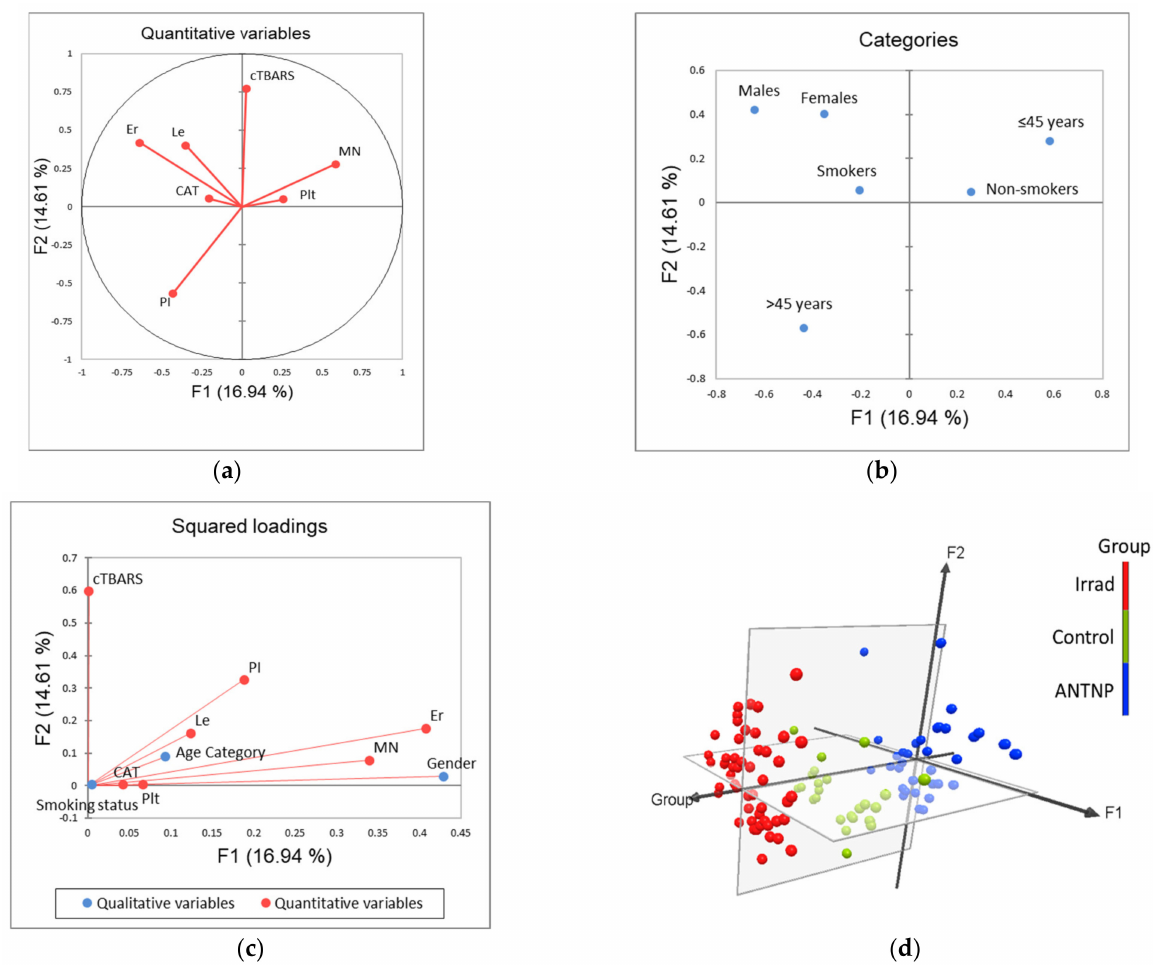
Figure 3. Principal component analysis: ( a ) correlation circle (quantitative variables); ( b ) factorial map of categories; ( c ) squared loadings of all evaluated variables; ( d ) position of evaluated cases in the space defined by the first two principal components. Control—unexposed volunteers; ANTNP—workers exposed to antineoplastic drugs; Irrad—workers exposed to ionizing